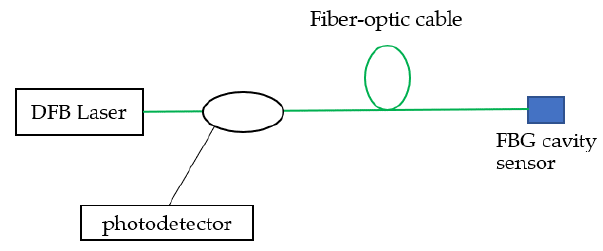
Figure 11. The distributed vibration sensor method.